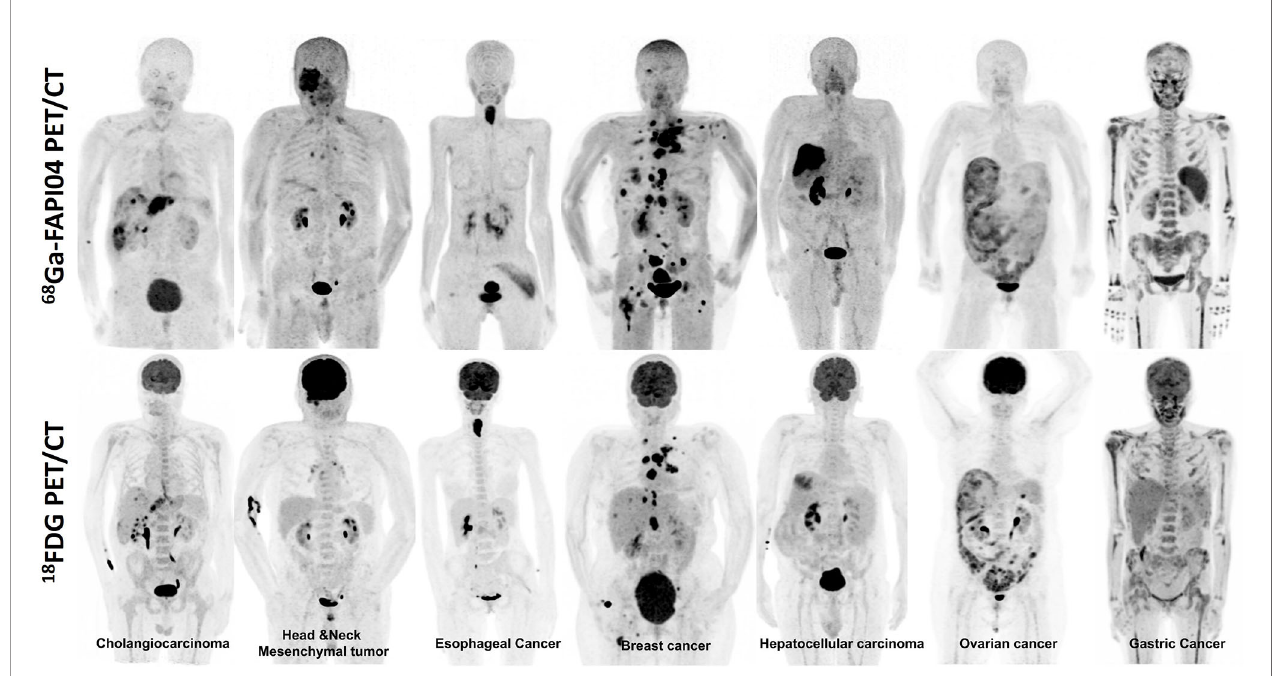
FIGURE 1 | Intraindividual comparison of 18 F-FDG and 68 Ga-FAPI04 PET maximum-intensity projection images of seven patients with various histopathologically proven tumors. The uptake of 68 Ga-FAPI04 is superior or equal to 18 F-FDG in the metastatic